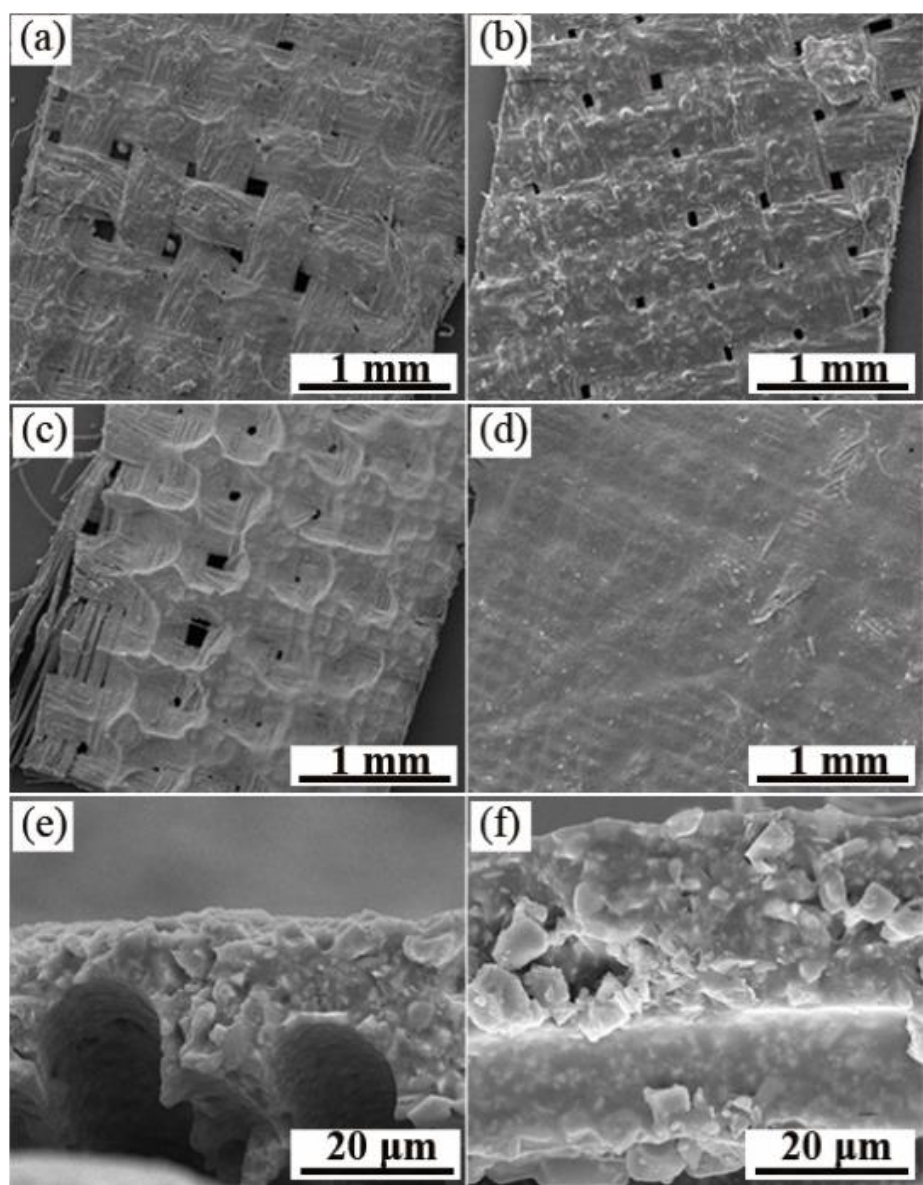
Figure 5. SEM images of the surface and interface of the coating. Coating surface on which the film-forming substance is present; ( a ) waterborne polyurethane; ( b ) PVP; ( c ) fluorocarbon resin; ( d ) fluorocarbon-resin-coated surface printed twice; ( e ) fluorocarbon-resin-coated cross-section printed once; and ( f ) fluorocarbon-resin-coated cross-section printed twice.